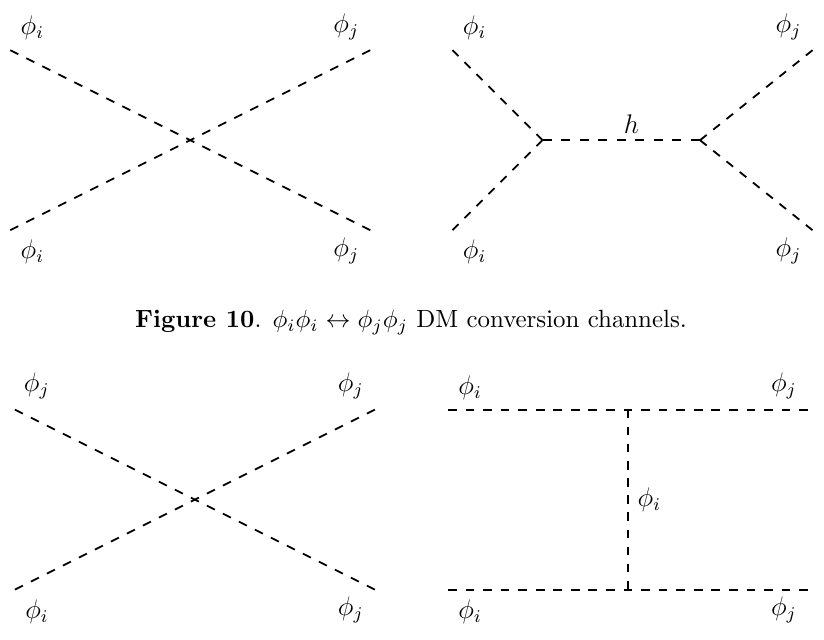
Figure 11 . (cid:30) i (cid:30) j ! (cid:30) j (cid:30) j DM conversion channels via quartic (left panel) and trilinear (right panel) interactions involving a linear term on (cid:30) i .